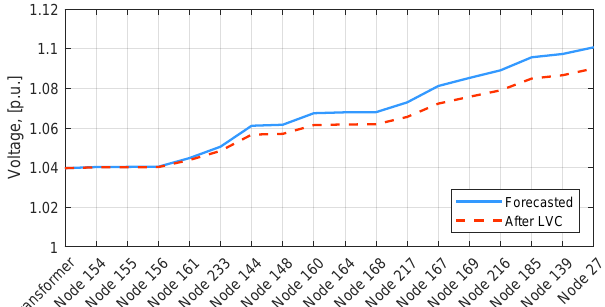
Figure 14. Worst voltage deviation. Comparison of the voltage profiles forecasted for the feeder and time instant where the worst voltage violation is forecasted to occur, with and without the application of the